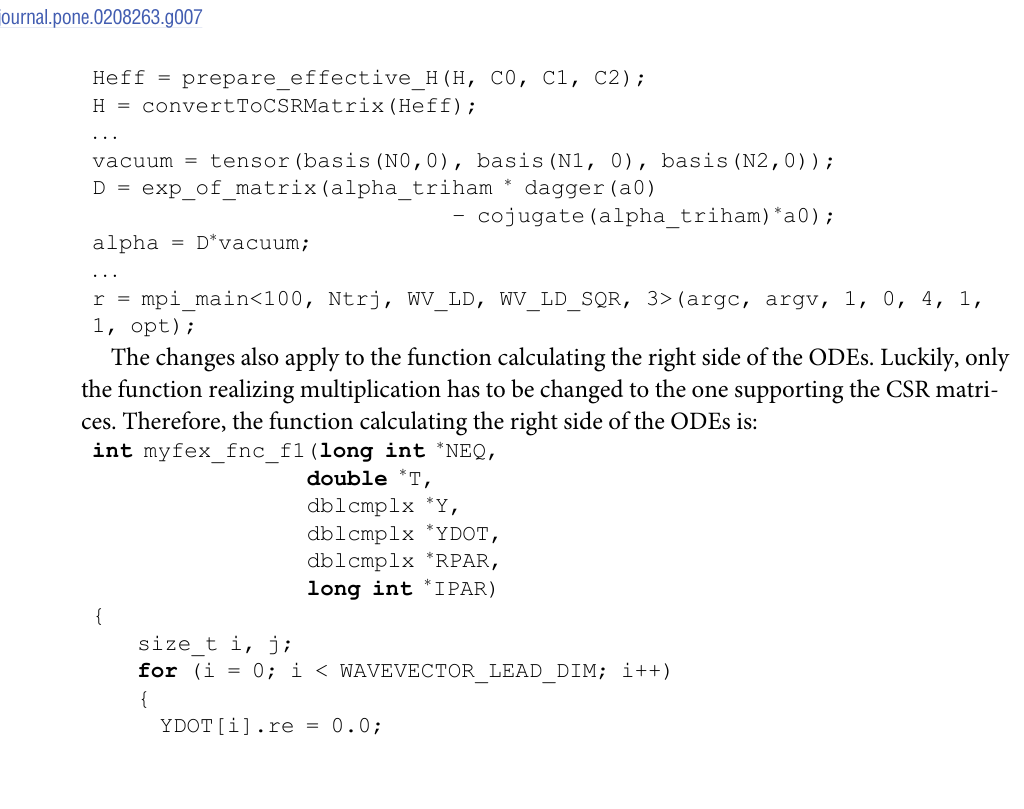
Fig 7. The duration of the simulation for the trilinear Hamiltonian. The experiments were run for the different number of trajectories with use of the QuTIP (four CPU cores were used), the QuantumOptics.jl (termed as QuanOpt, with only one CPU core used during the computations), and the QTM package (with two different numbers of the computational